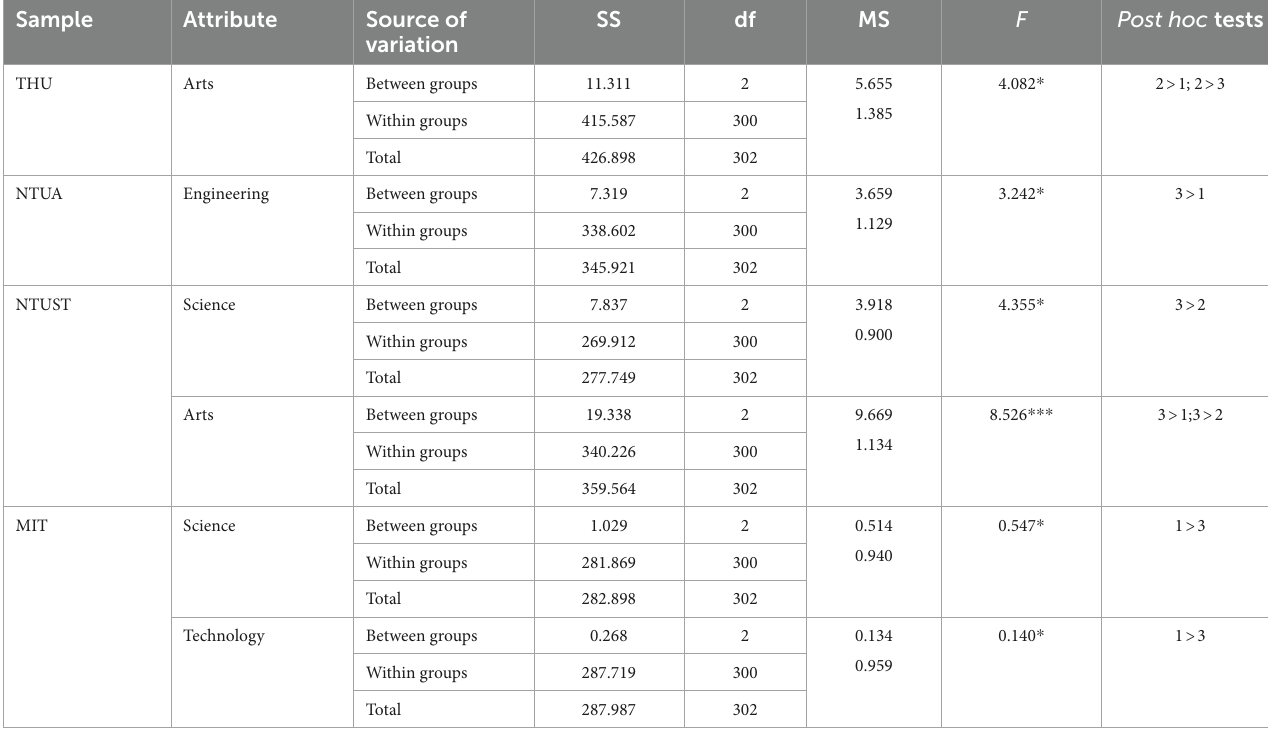
TABLE 7 The differences between subjects in the three versions.